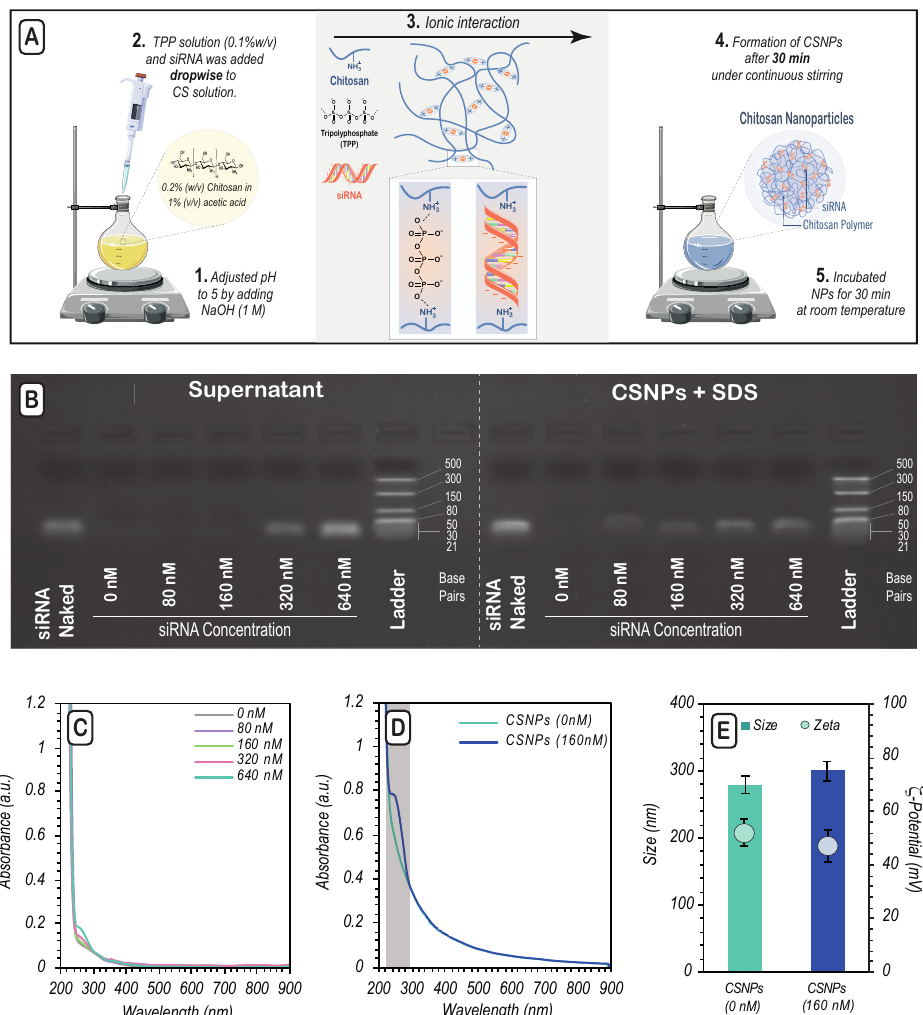
Figure 3. Synthesis of crosslinked CSNPs for siRNA delivery, ( A ) Schematic representation of CSNPs synthesis with the crosslinking method. ( B ) Agarose gel retardation assay of CSNPs with siRNA as a function of siRNA concentration. ( C ) UV-Visible spectra of the supernatant obtained after centrifugation, for CSNPs loaded with different amounts of siRNA. ( D ) UV-Visible spectra of CSNPs prepared in the absence or presence of 160 nM siRNA. ( E ) Average hydrodynamic particle diameter and zeta-potential of CSNPs with or without